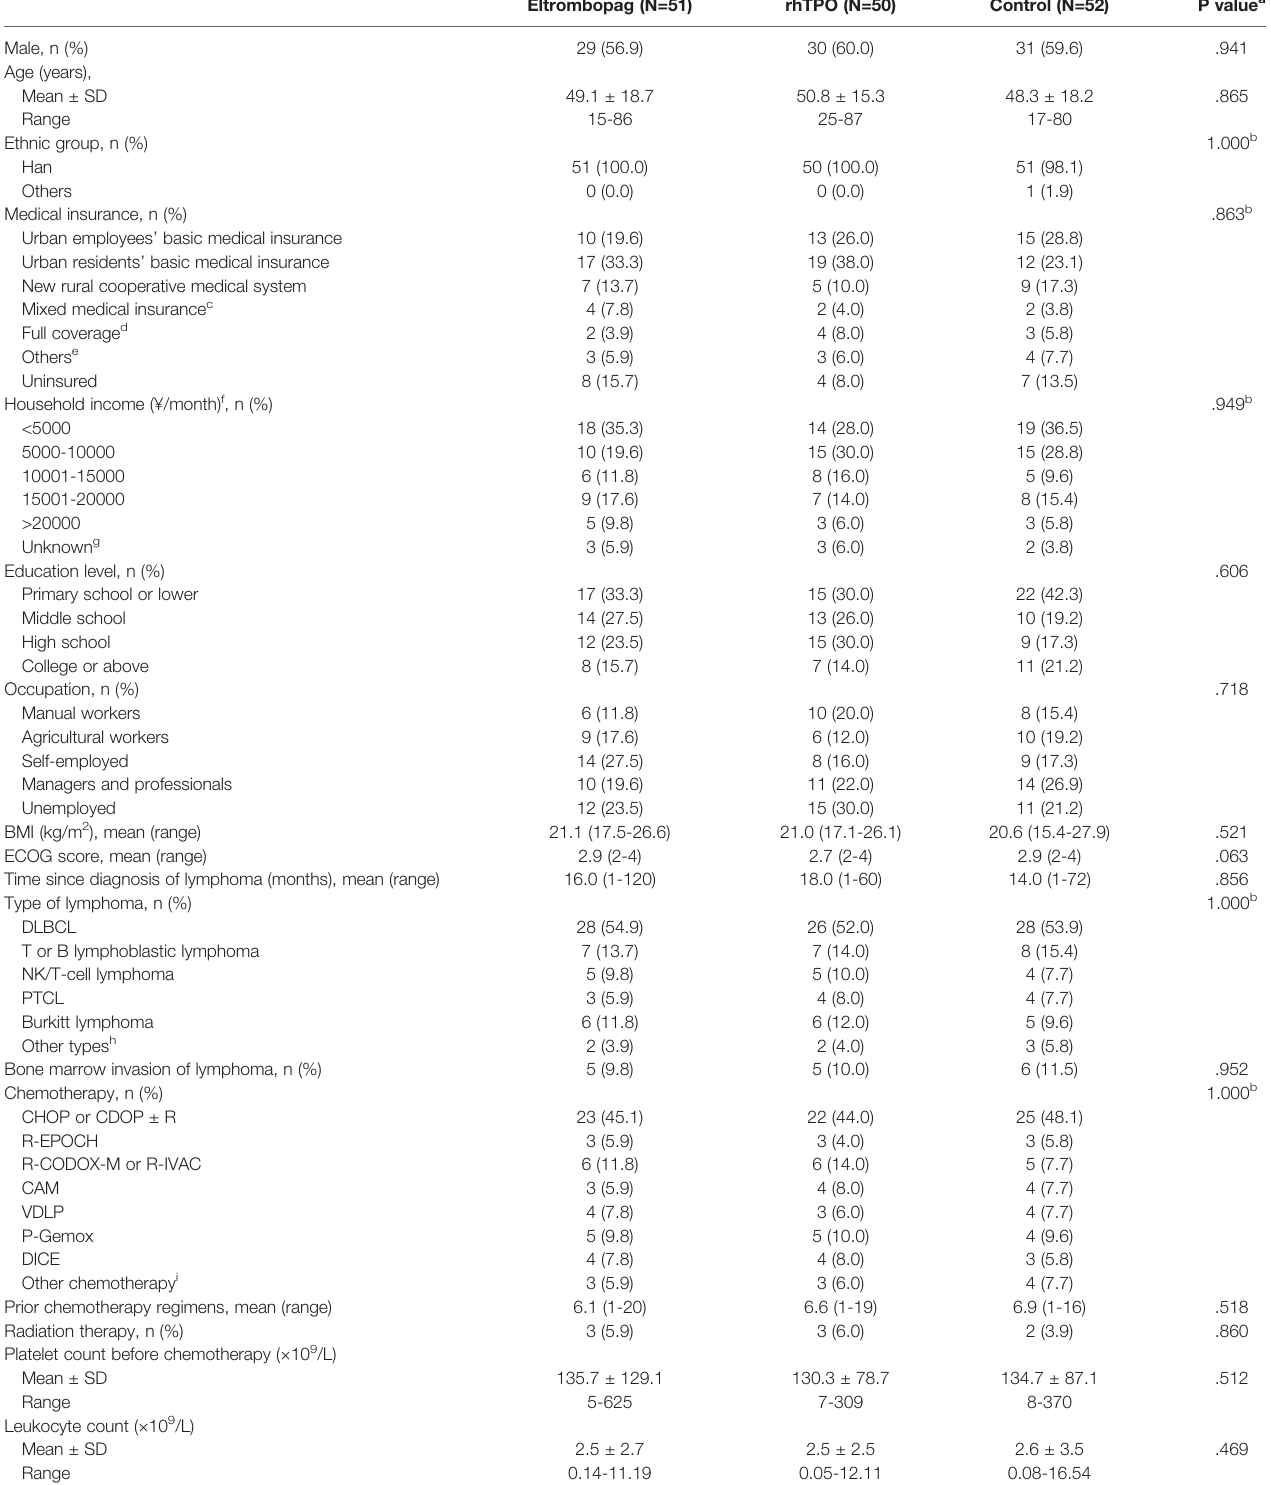
TABLE 1 | Demographic, socioeconomic, and baseline